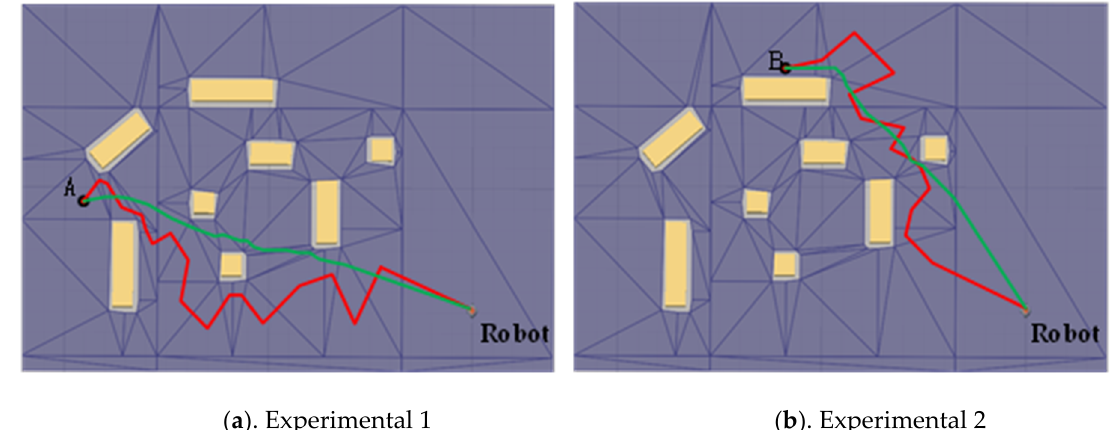
Figure 22. Experimental path planning results.